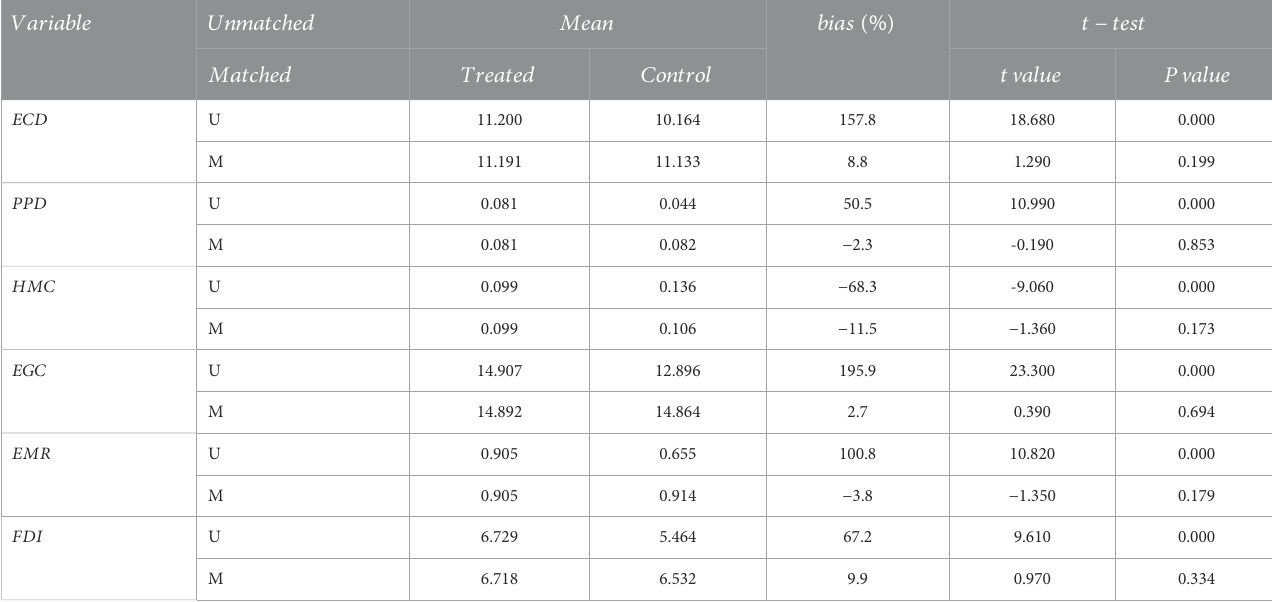
TABLE 3 The result of balance test.